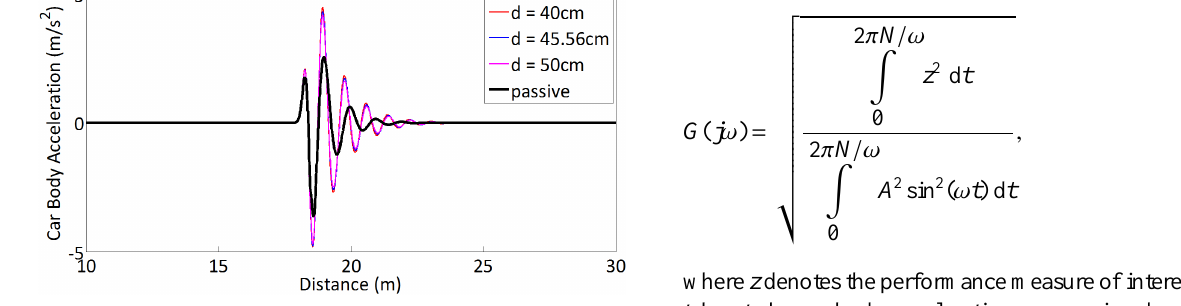
Figure 10. Time Domain Simulation: Car Body Acceleration.